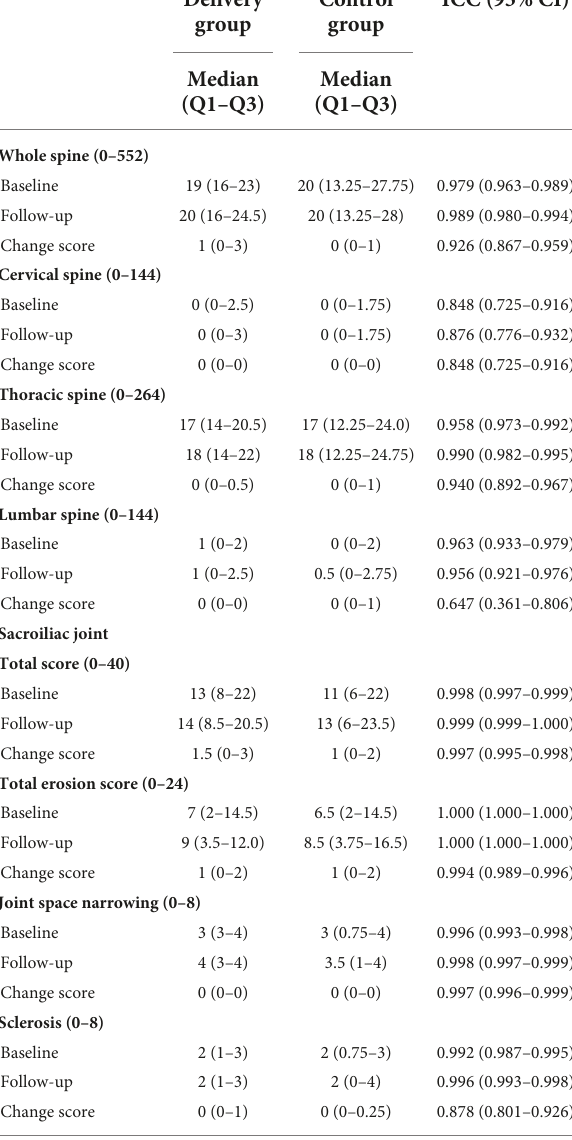
TABLE 2 Changes in computed tomography (CT) scores over time in r-axSpA women with and without